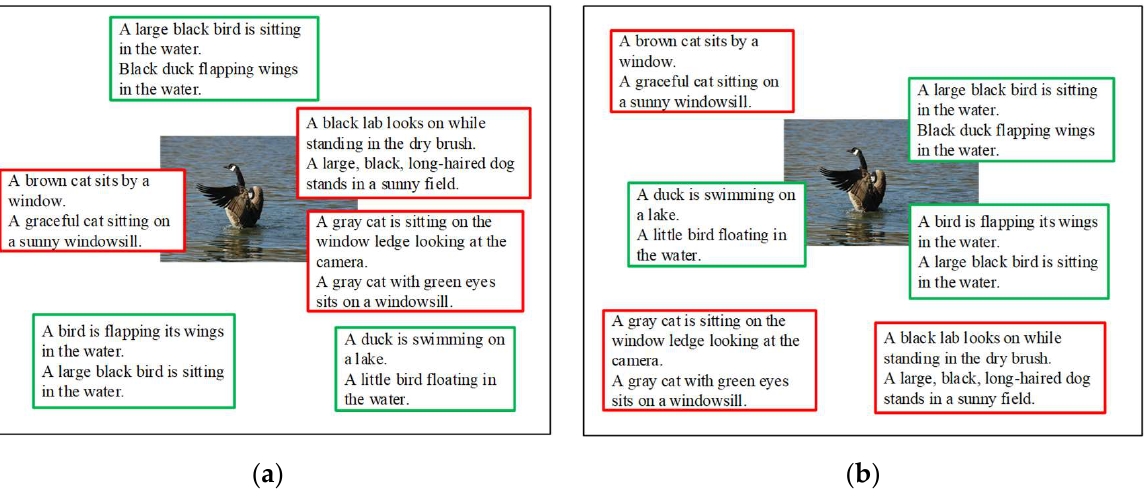
Figure 3. The distance relation preserving among triplet samples in the common space. ( a ) The sample distribution without the triplet similarity preserving constraint. ( b ) The sample distribution with the triplet similarity preserving constraint.